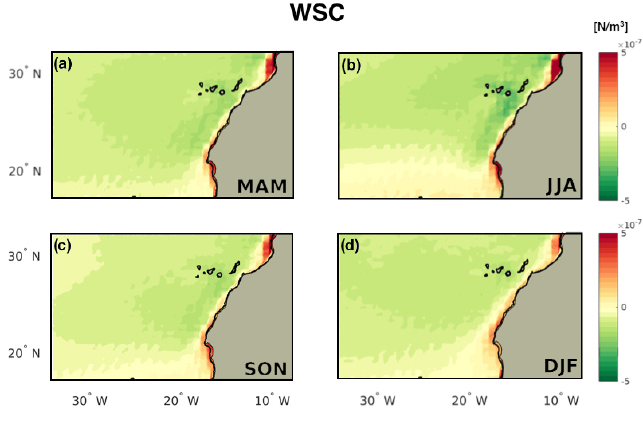
Figure B5. Seasonality of wind stress curl.